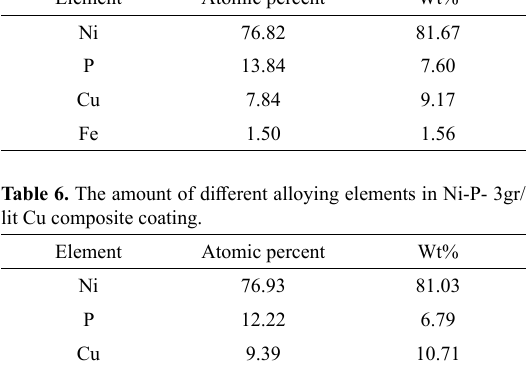
Table 5. The amount of different alloying elements in Ni-P- 1gr/ lit Cu composite coating. Element